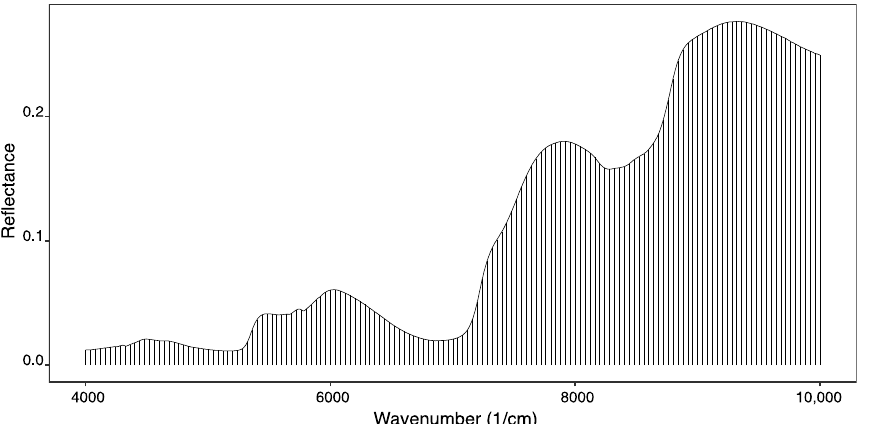
Figure 3. Average of the smooth spectra and the 151 points selected to represent the overall infor-